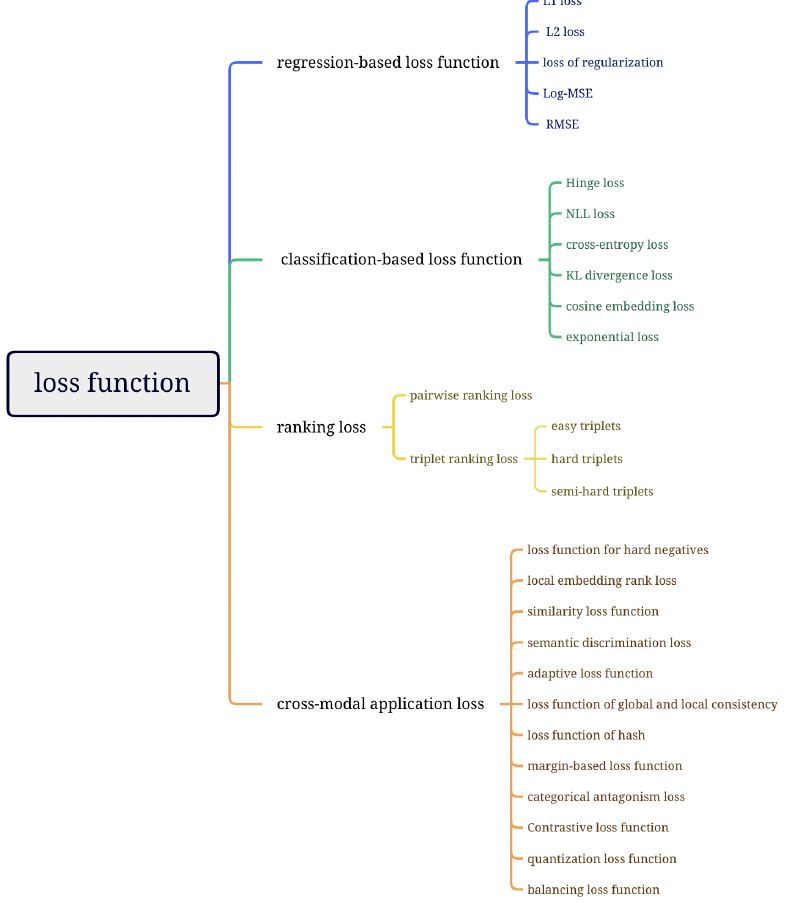
Figure 4. Innovative samples of the loss